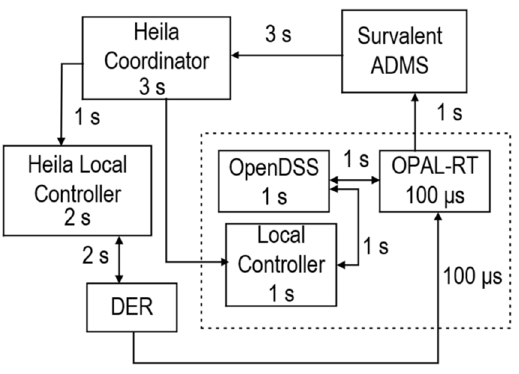
Figure 8. The integrated HIL simulation with multiple time steps.